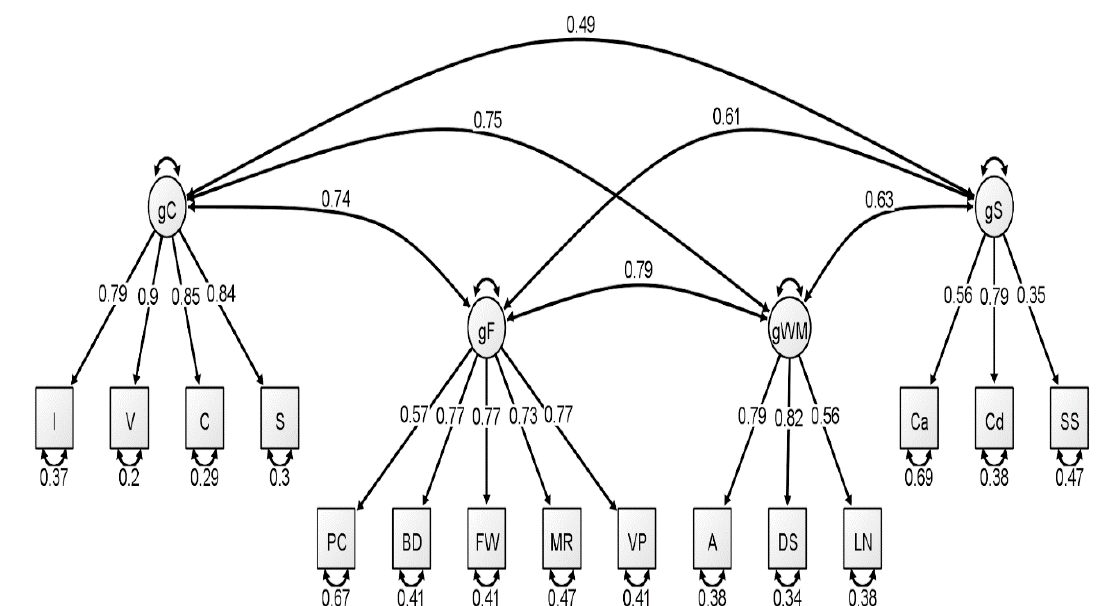
Figure 2. Correlated four-factor measurement model of the middle group WAIS-IV correlation matrix. All values are